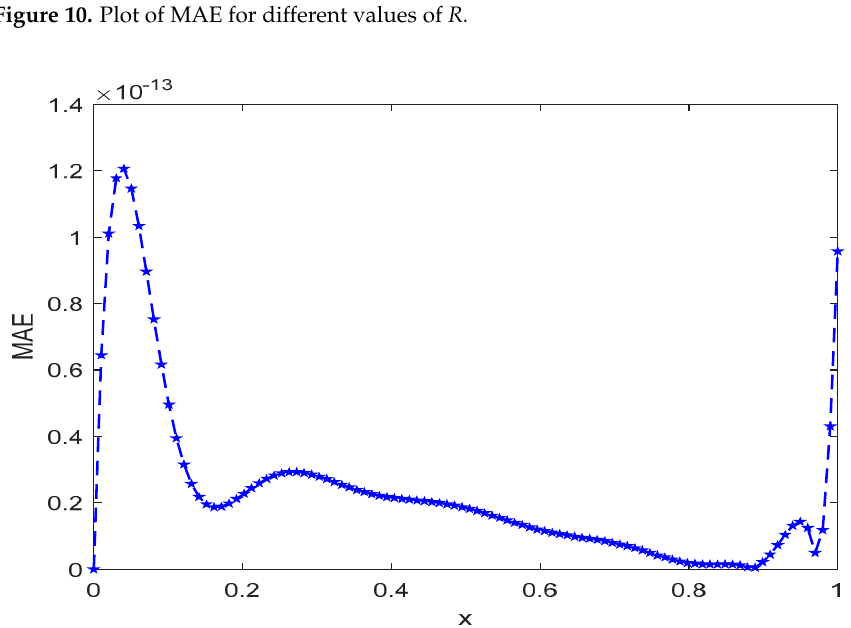
Figure 11. Plot of MAE Example 𝟓 for 𝑹 = 𝟏𝟐 .